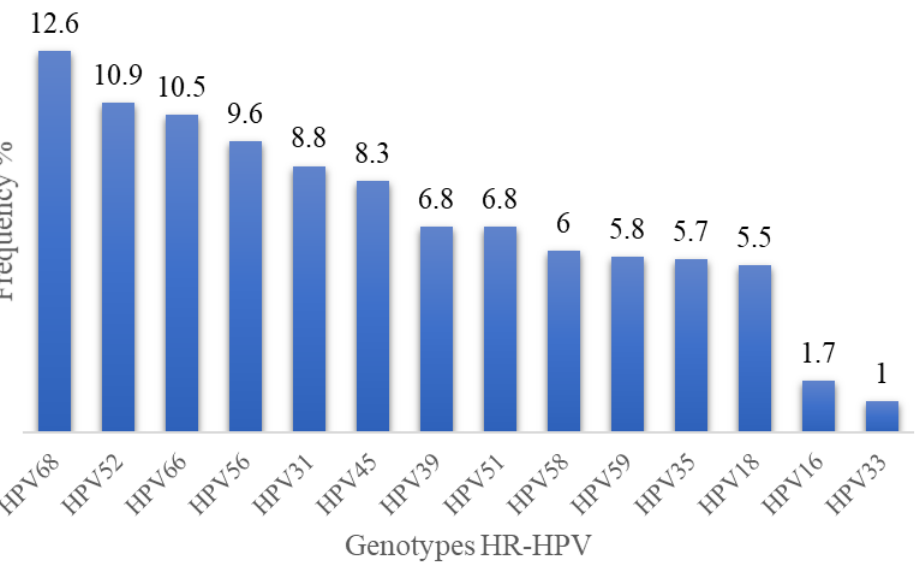
Figure 1: Frequency of high-risk HPV genotypes found in swab-type specimens from women with or without cervical dysplasia.